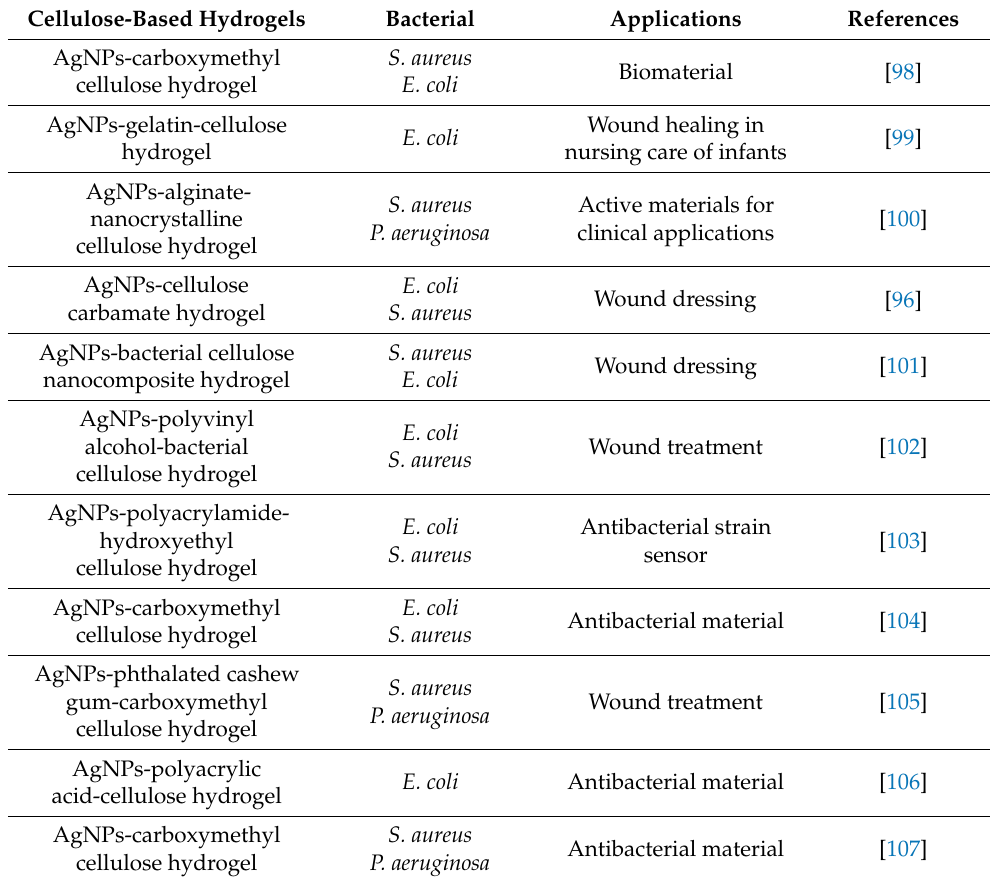
Table 2. Representative examples of cellulose-based hydrogels loaded with